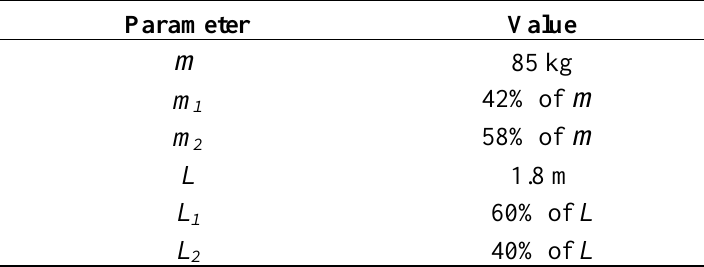
Table 2. Parameter values for two-link